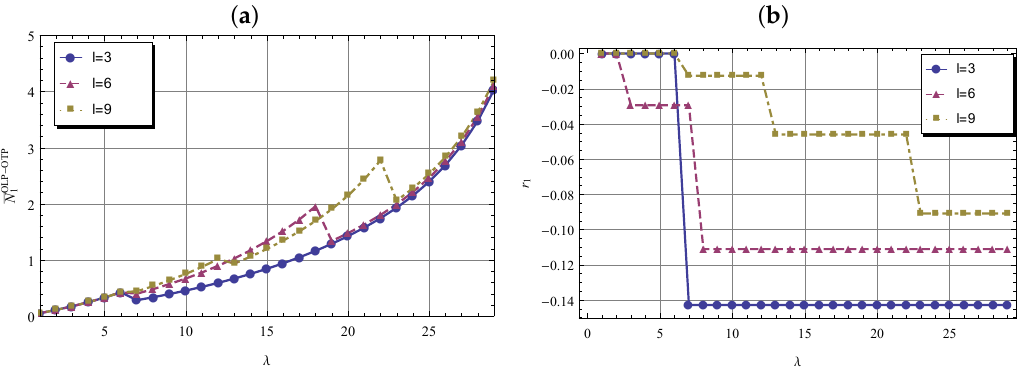
Figure 3. ¯ N f ( a ) and r 1 ( b ) versus λ and l 1